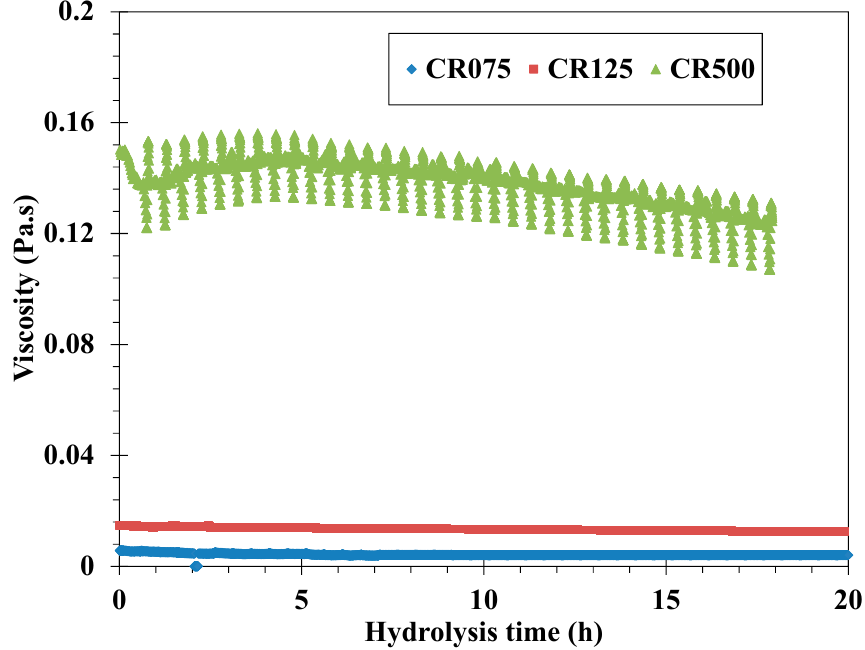
Figure 5. In-situ viscosimetry as a function of hydrolysis time (CR075, CR125, and CR500 are cassava flour with the particle sizes of under 75 µm, 75–125 µm, and 250–500 µm, respectively). The evolution of the non-Newtonian behavior of cassava flour suspension during hydrolysis was observed by in-situ rheometry. A sweep of mixing rate cycle (125, 100, and 75 rpm, which corresponds to shear rates equal to 80, 64, and 48 s − 1 , respectively) was reported every 30 min. Taking only the points at laminar and transitory regimes (Re ≤ 600) into consideration, the power-law index was deduced from Equation (4). It is no- ticeable that the flow behavior index increased as a function of hydrolysis time (Table 4).